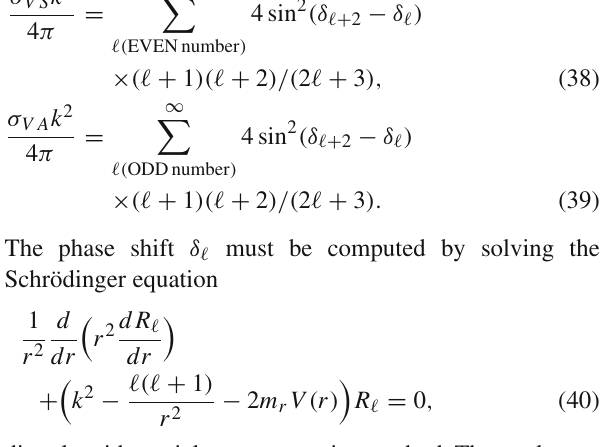
dark scalar is below a few